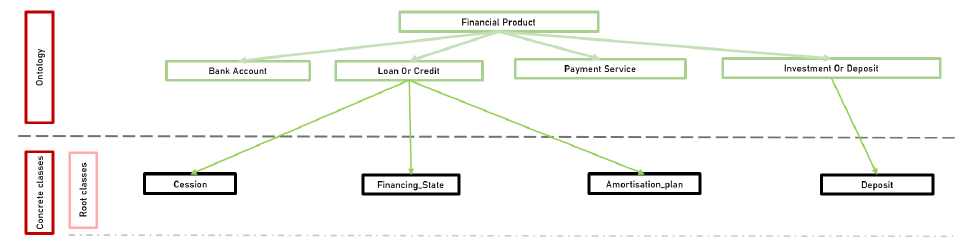
Figure 8. Concreting Relationships defined for the running